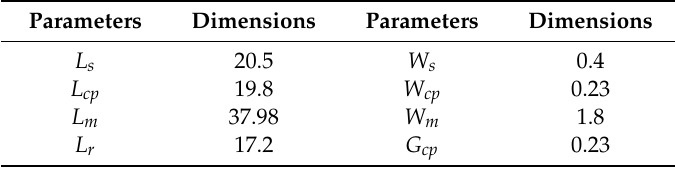
Figure 10. Simulated S 21 comparison of uniform transmission lines and PCLs integrated with λ g / 4 short-ended stubs at input and output ports. ( a ) wideband state, ( b ) narrowband state. Table 3. Design dimensions for λ g / 2 short-ended stubs (Units: